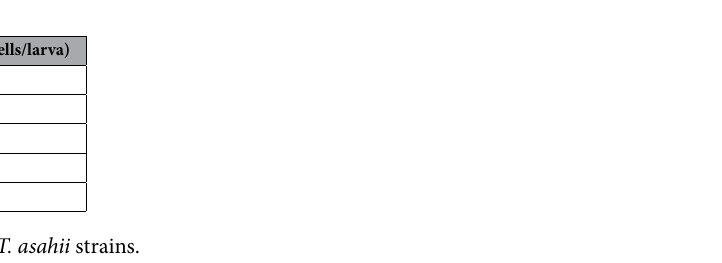
Figure 5. Attenuated pathogenicity in the cna1 or the cnb1 gene-deficient T. asahii mutants against silkworms. ( a , b ) The T. asahii parent strain (Parent; 2.9 × 10 5 cells/larva), the cna1 gene-deficient mutant (∆ cna1 ; 7.4 × 10 5 cells/larva), the revertant from ∆ cna1 (CNA1; 4.2 × 10 5 cells/larva), the cnb1 gene-deficient mutant (∆ cnb1 ; 6.1 × 10 5 cells/larva), or the revertant from ∆ cnb1 (CNB1; 7.1 × 10 5 cells/larva) were injected into the silkworm hemolymph and the silkworms were incubated at 37 °C. Silkworm survival was monitored for 72 h. The significance of differences between the parent strain group and the cnb1 gene-deficient mutant groups was calculated by the log-rank test based on the curves by the Kaplan–Meier method. P < 0.05 was considered significant. n = 10/group. ( c , d ) Number of surviving silkworms at conditions under 37 °C was determined at 48 h after administration of the fungal cells (50 to 1.2 × 10 6 cells/larva) into the silkworm hemolymph. Surviving and dead silkworms are indicated as 1 and 0, respectively. n = 4/group. Curves were drawn from combined data of 2–3 independent experiments by a simple logistic regression model.